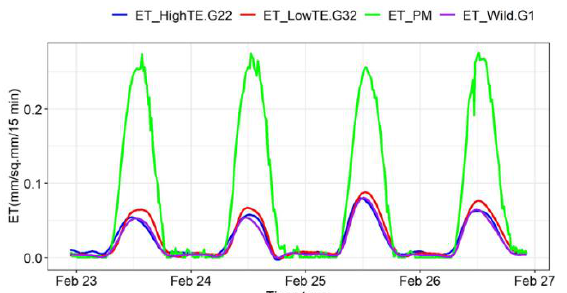
Figure 2. Comparison of smooth ET time series (stage-2 pre- processing) of three different genotypes and reference ET (ET_PM)